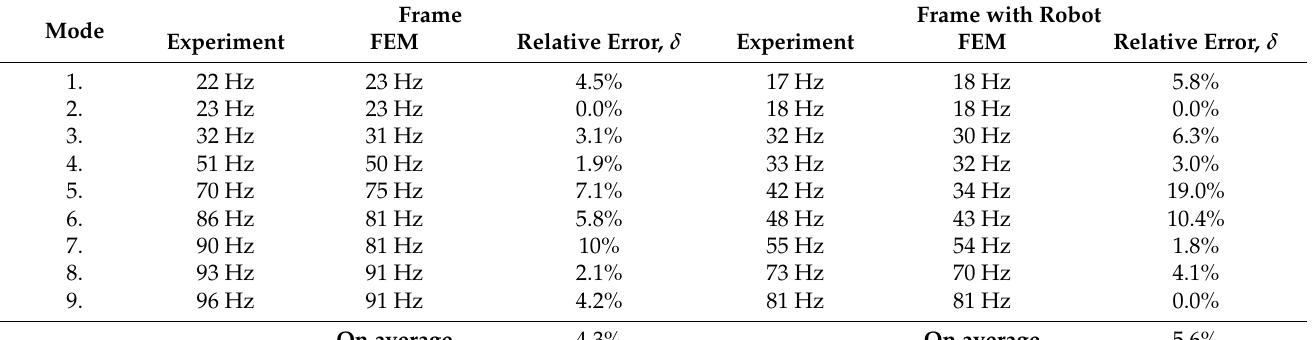
Table 2. Experimental verification of the natural frequencies of the frame and the frame with the robot.